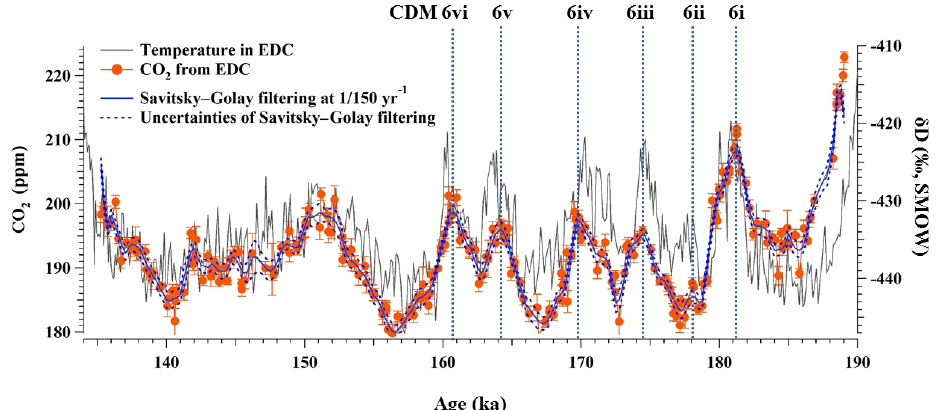
Figure 5. Composite atmospheric CO 2 (left axis) from the EDC ice core (this study) compared to the EDC water isotopic record (right axis) (Jouzel et al., 2007). The blue line indicates a Savitzky–Golay filter using a 150-year cut-off period (dotted blue line). Vertical dotted blue lines indicate the six CDM events that we identify during the early MIS 6. The numbers of the CDM events are indicated at the top of the